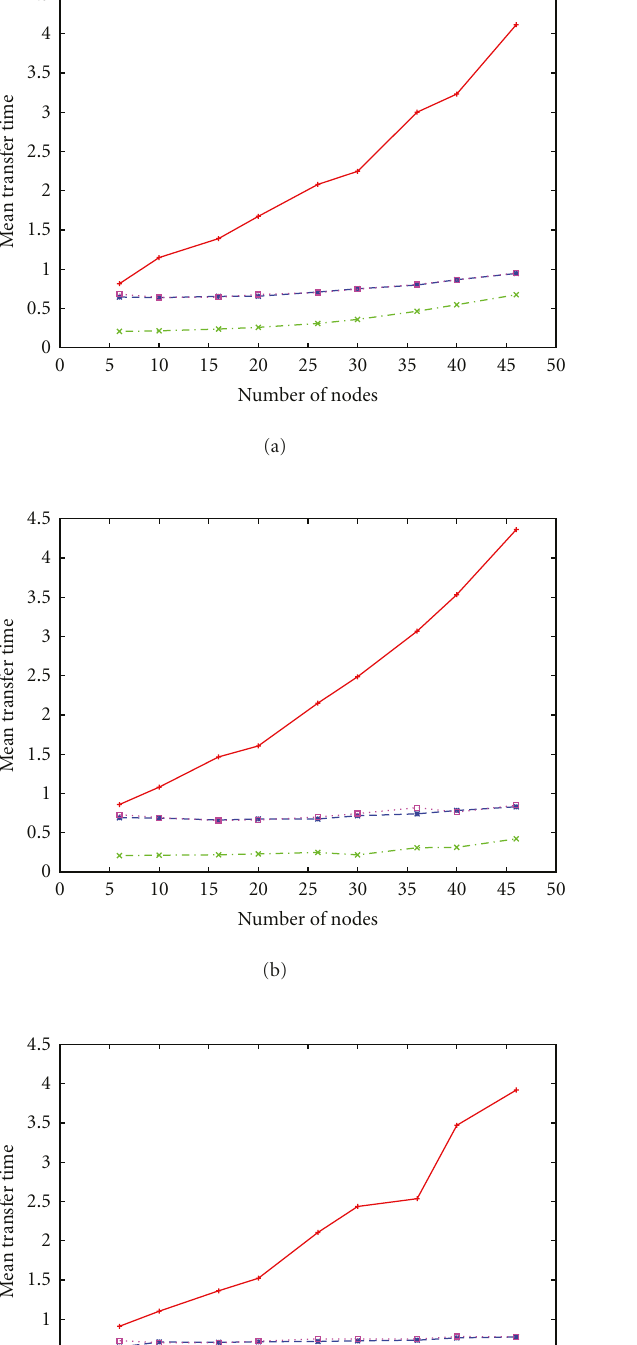
Figure 8: Mean transfer time of small files for short flow interarrival time: (a) 250 ms; (b) 500ms; (c) 1 second.